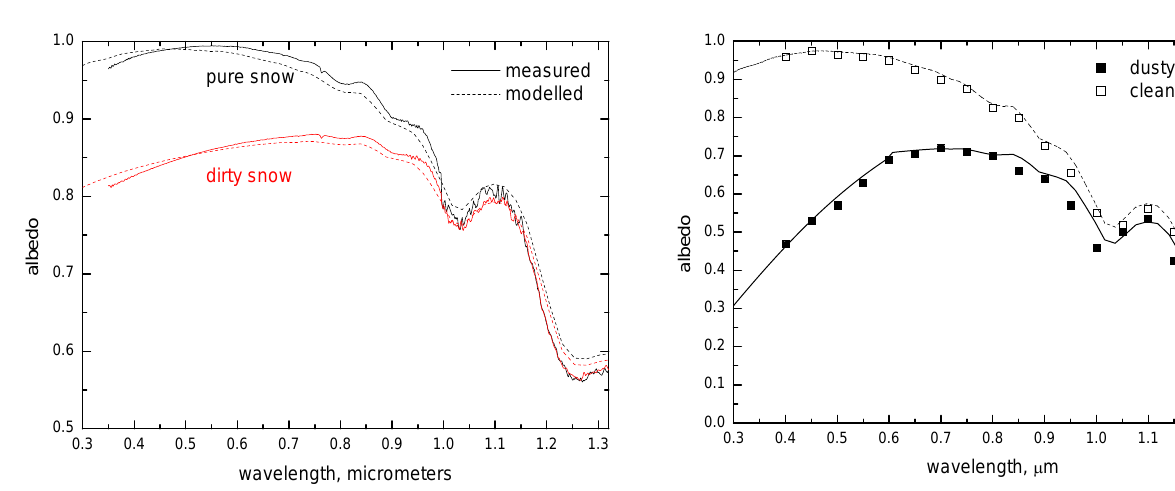
Fig. 3. The spectral dependence of clean and dusty snow spherical albedo at c = 0 . 22mgg − 1 and a ef = 400µm (for clean snow), a ef = 450µm (for dusty snow). The results of calculations are given by lines. Symbols represent experimental measurements (Painter et al.,